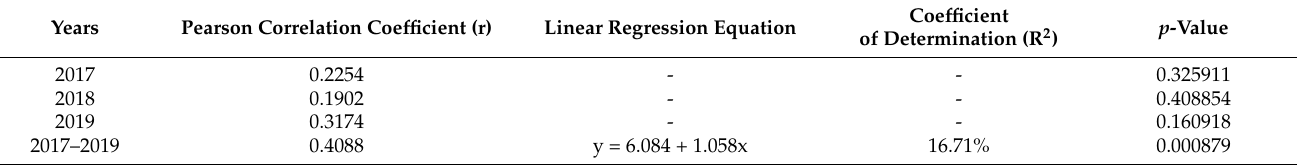
Table 14. Linear relationships between grain yield and calcium content in maize leaf blades at BBCH